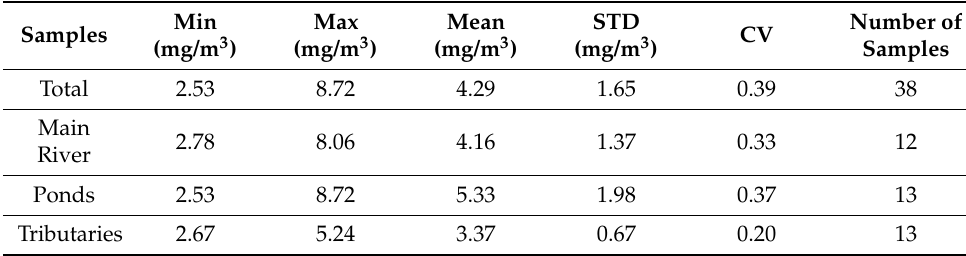
Table 1. Descriptive statistics of the chl-a concentration of the